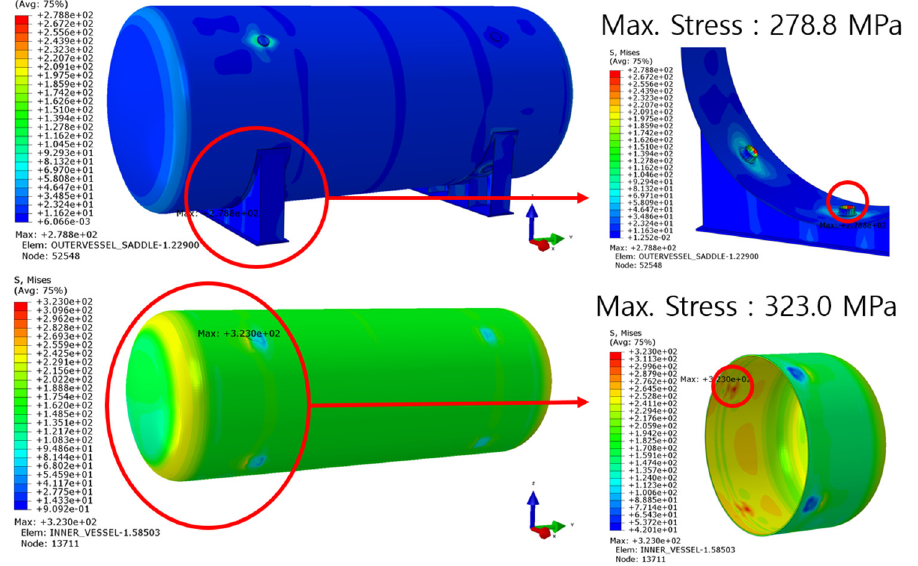
Figure 13. Stress contour of strength evaluation in transverse acceleration (SUS304).